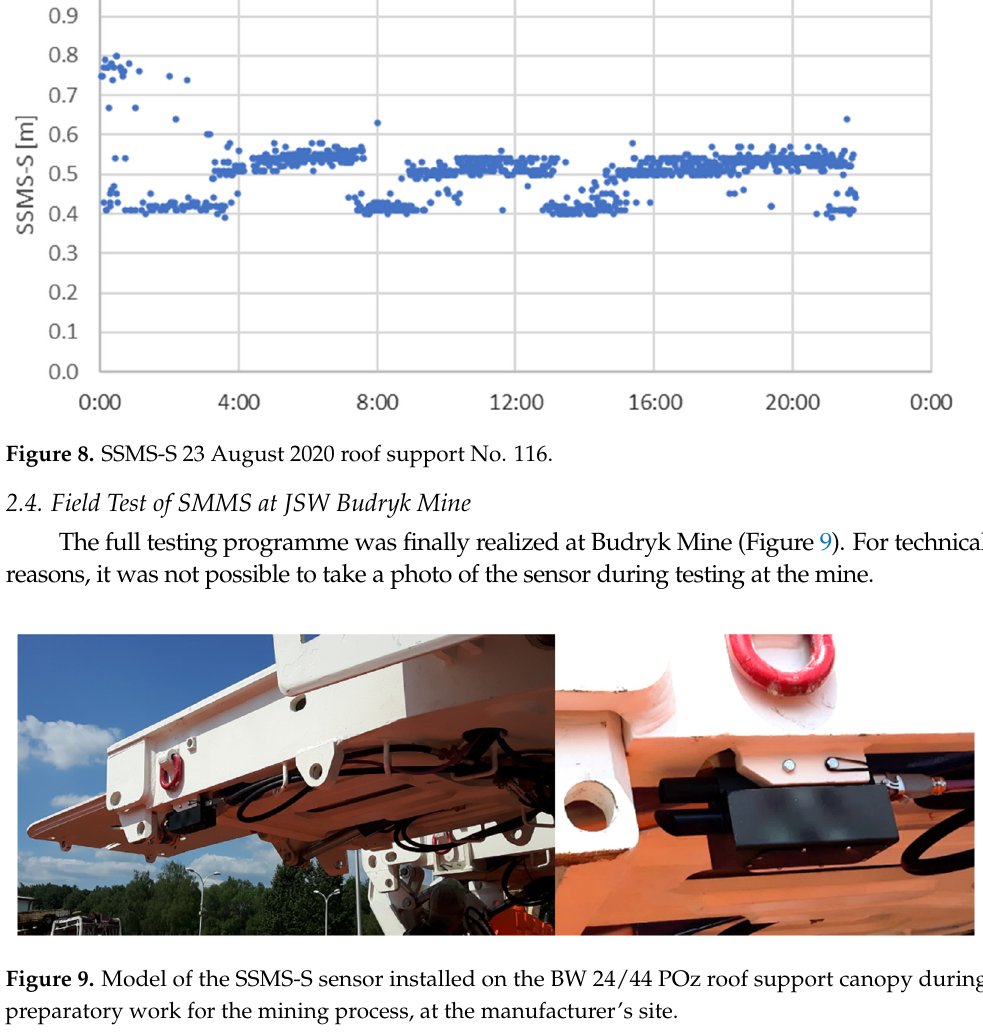
Figure 7. SSMS-S sensor in operation: harsh conditions.